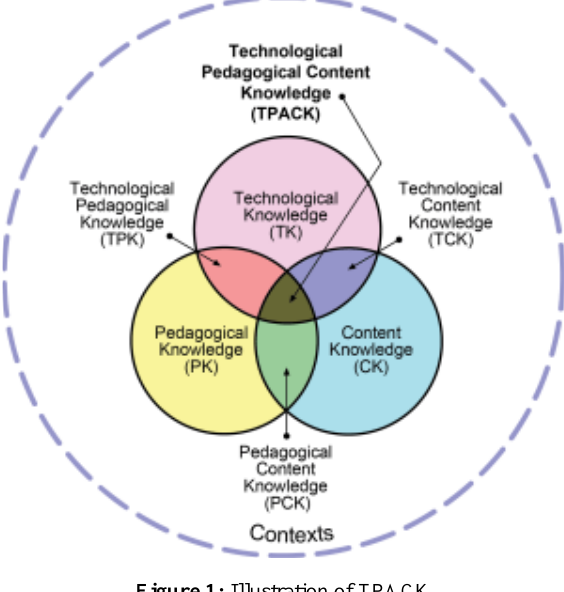
Figure 1: Illustration of